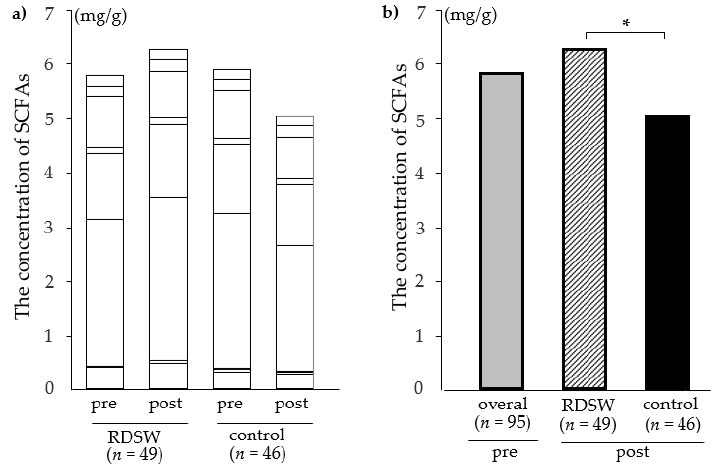
Figure 3. Effect of drinking RDSW or mineral water on fecal short-chain-fatty-acids (SCFAs) concentrations through the intervention (average). ( a ) The combined amounts of nine SCFAs increased in the RDSW group and decreased in the control group. The following nine SCFAs were analyzed, from bottom to top: succinic acid, lactic acid, formic acid, acetic acid, propionic acid, isobutyric acid, butyric acid, 3-methylbutanoic acid, and valeric acid. Formic acid is not listed due to its extremely small amounts. ( b ) The change in the combined amounts of SCFAs was observed with a 23% difference between two groups. Shaded bar, all subjects; hatched bar, RDSW group; black bar, control group; pre, pre-intervention; post, post-intervention; * p < 0.05.